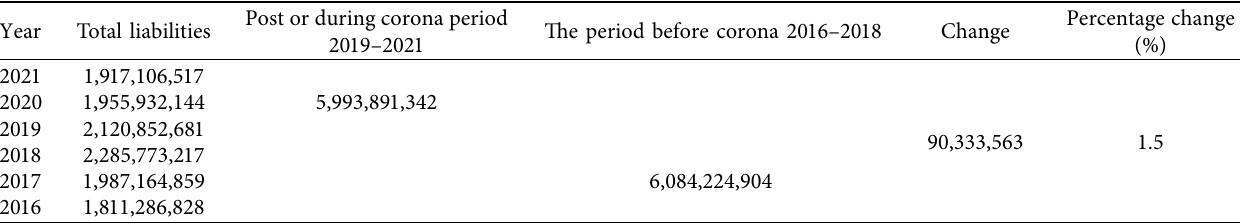
Table 2: Te evolution of the liabilities of the study sample companies before and after the efects of the Corona pandemic. Year Total liabilities